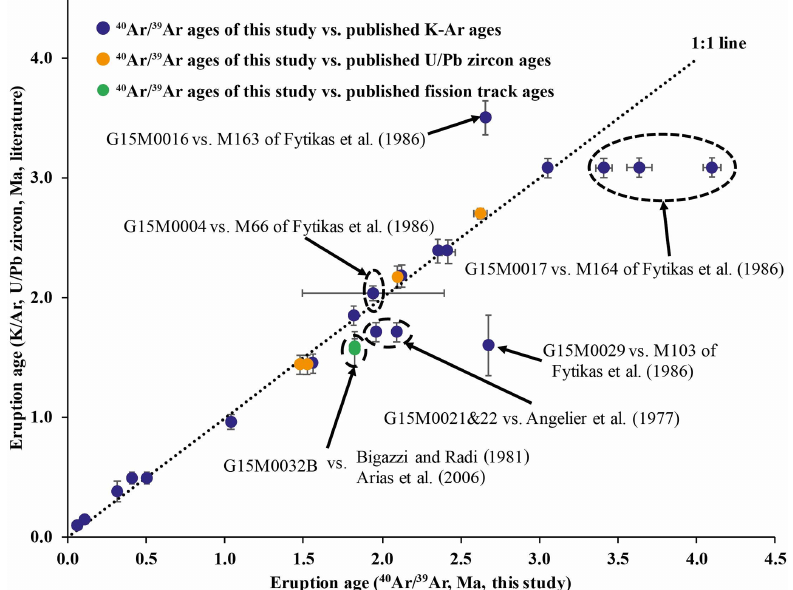
Figure 12. The 40 Ar / 39 Ar ages of this study ( x axis) compared to the K −− Ar ages (Angelier et al., 1977; Fytikas et al., 1986), U–Pb zircon ages (Stewart and McPhie, 2006) and fission track ages (Bigazzi and Radi, 1981; Arias et al., 2006) ( y axis) for the same volcanic units. Ages which deviate from the 1 : 1 correlation line are discussed in Sect.